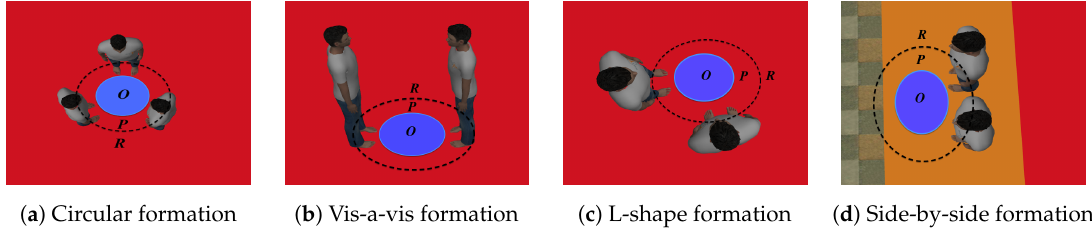
Figure 2. Kendon’s F-formations, these define three social spaces: O-space is the convex empty space between the people in a formation. P-space is the narrow strip on which people are standing while conversing, and R-space is the space beyond P-space.